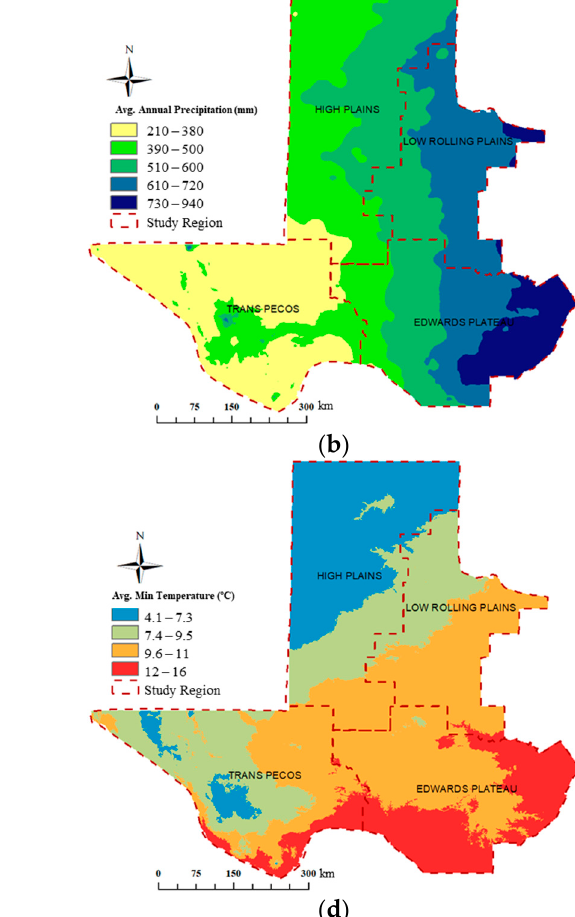
Figure 1. ( a ) Texas elevation map and its climate divisions; ( b ) mean annual precipitation; ( c ) mean annual maximum temperature; and ( d ) mean annual minimum temperature.